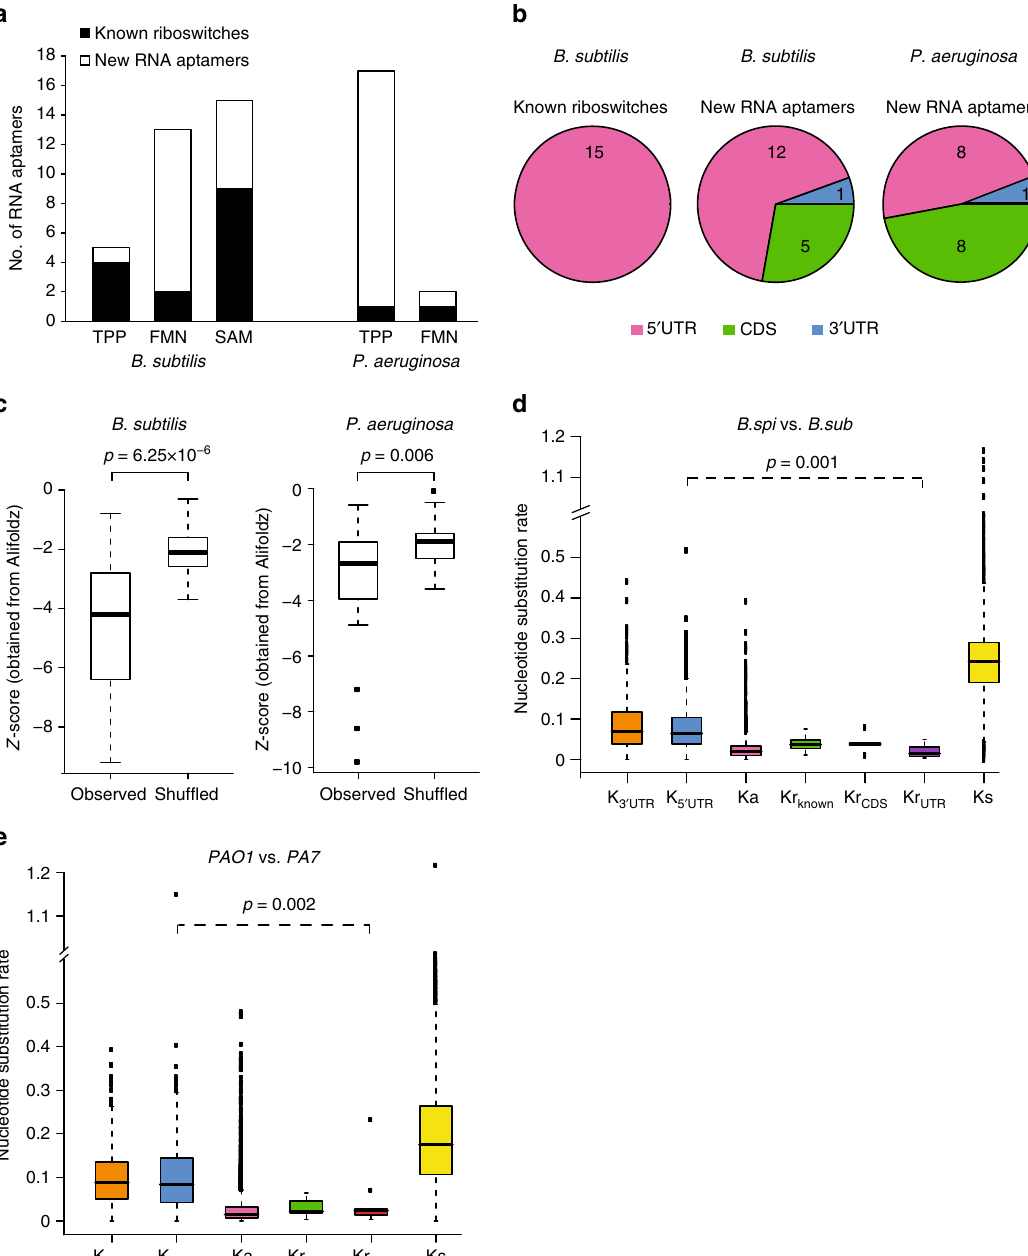
Fig. 2 PARCEL identi fi es new RNA aptamers in bacterial species. a PARCEL identi fi es a total of 52 RNA aptamers in B . subtilis and P . aeruginosa . Black and white bars indicate the numbers of known riboswitches and novel aptamers that are identi fi ed in our study, respectively. b Distribution of known riboswitches and new RNA aptamers along the 5 ′ UTR, CDS, and 3 ′ UTR regions for B . subtilis and P . aeruginosa , showing that a substantial proportion of RNA aptamers are located in the 3 ′ UTR and CDS regions. c Comparison of score distribution of Alifoldz 12 for RNA aptamers vs. shuf fl ed counterparts. The upper, middle, and lower bounds of the boxplot represent the 75, 50, and 25th percentile of the values, respectively. A negative score indicates a stable, conserved consensus structure. p -value was obtained using the non-parametric Kolmogorov – Smirnov test. d, e Comparison of the nucleotide substitution rate (number of substitutions per base-pair) for new RNA aptamers in coding region (Kr CDS ), new RNA aptamers in UTR (Kr UTR ), 3 ′ UTR (K 3UTR ), 5 ′ UTR (K 5UTR ), synonymous sites (Ks), and non-synonymous sites (Ka). The upper, middle, and lower bounds of the boxplot represent the 75, 50, and 25th percentile of the values, respectively. To calculate nucleotide substitutions, B . subtilis 168 was compared to B . subtilis subsp . spizizenii W23 ( d ), and P . aeruginosa PAO1 was compared to P . aeruginosa PA7 ( e ). Note that Kr known denotes the substitution rate of known riboswitches in B . subtilis (15 in total) as annotated in the RegPrecise database 11 . Kr known was not calculated in P . aeruginosa as there are too few known TPP and FMN riboswitches. p -values were calculated using the non-parametric Kolmogorov – Smirnov